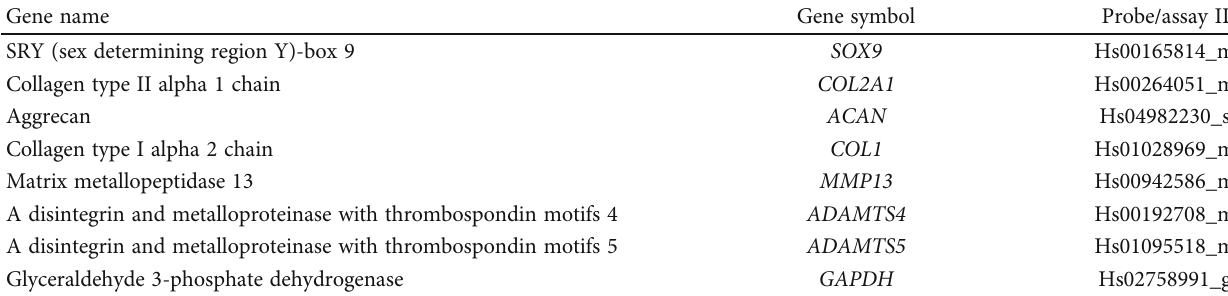
Table 1: Taqman assays used for qPCR on MSC-EV (both OA- and H-EVs) treated